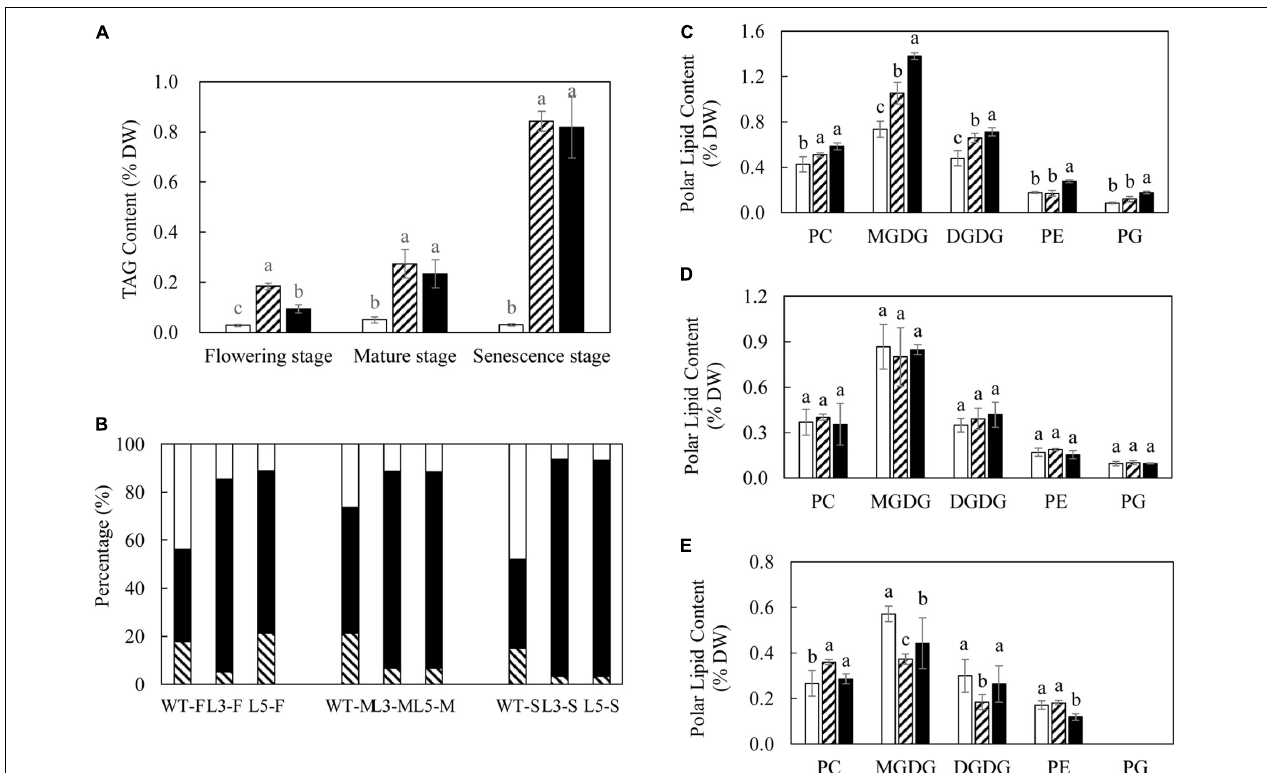
FIGURE 3 | Lipid dynamics in potato leaves at the three developmental stages. (A) TAG content in WT (open bar), L3 (bar with upward diagonal) and L5 (black bar); (B) Proportional variations of DAG (bar with downward diagonal), TAG (black bar) and FFA (open bar) at the flowering (F), mature (M), and senescent (S) stages. (C) Polar lipids content at the flowering stage in WT (open bar), L3 (bar with upward diagonal) and L5 (black bar); (D) Polar lipids content at the mature stage in WT (open bar), L3 (bar with upward diagonal) and L5 (black bar); (E) Polar lipids content at the senescent stage in WT (open bar), L3 (bar with upward diagonal) and L5 (black bar). The data represent the mean values ± SD of three biological replicates. Letters (a, b, c, and d) above the bars are based on LSD, bars marked with different letters are statistically significantly different at P <